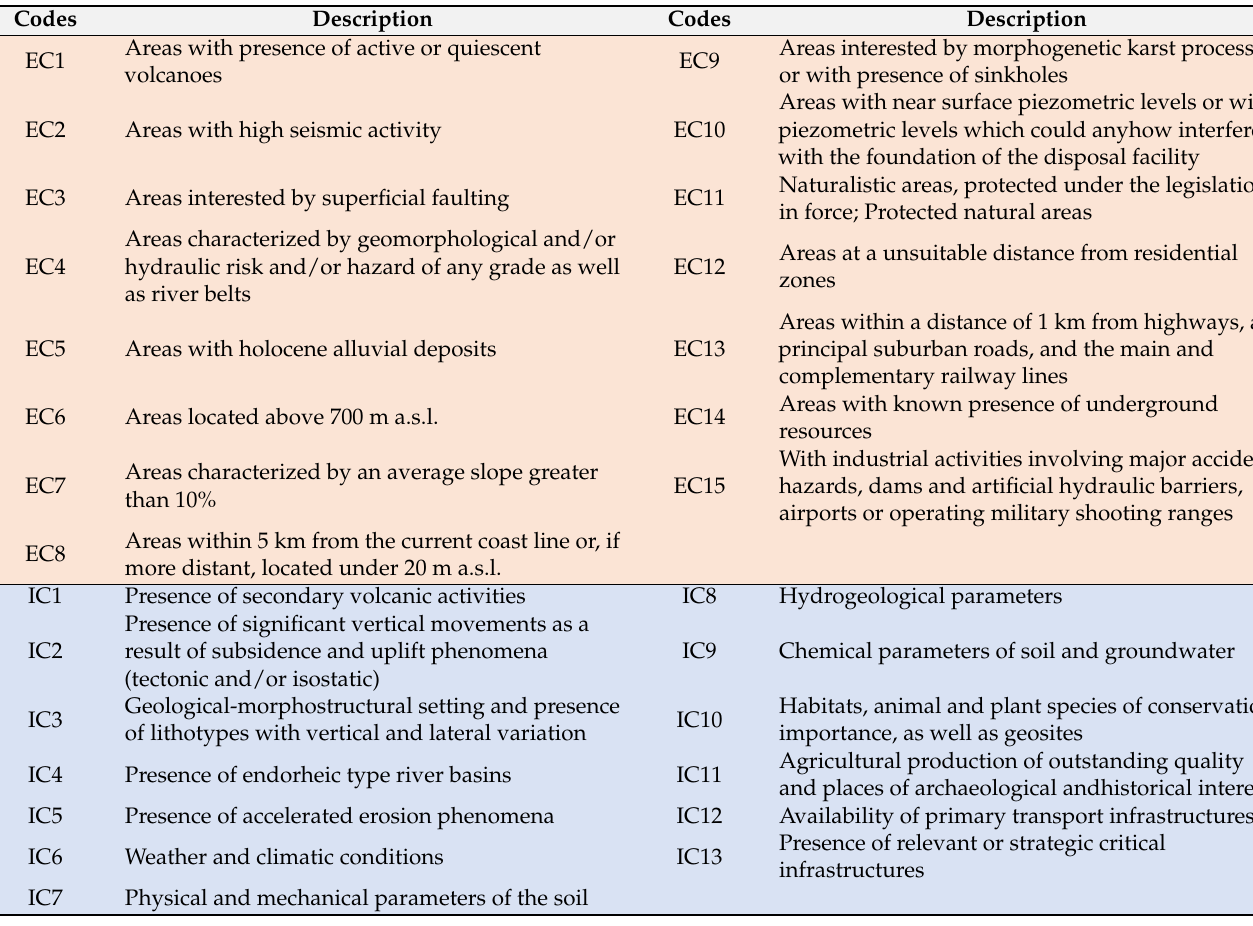
Table 1. Codes and meaning of the ISPRA/ISIN EC and IC criteria as reported in [12]. This work focused on only some of them (namely EC2, EC3, EC4, EC5, EC10, EC12, IC2, IC3, and IC8) with reference to TO-10 site.